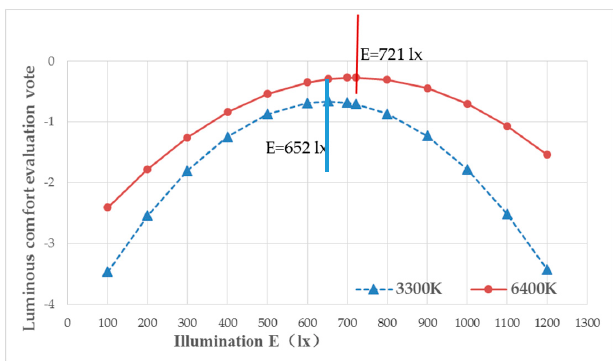
Figure 10. Non-dimensional function curve of luminous comfort (3300 K/6400 K).